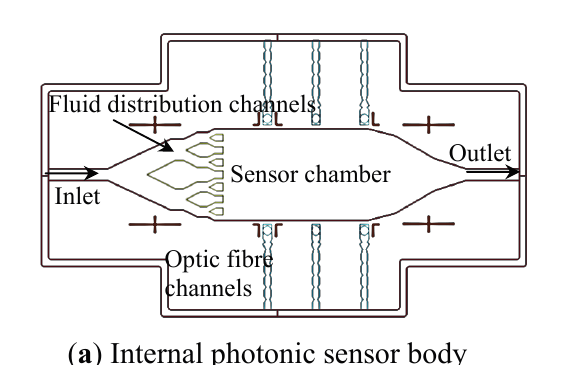
Figure 1. Internal photonic biosensor ( a ) schematic of the sensor body ( b ) photo of